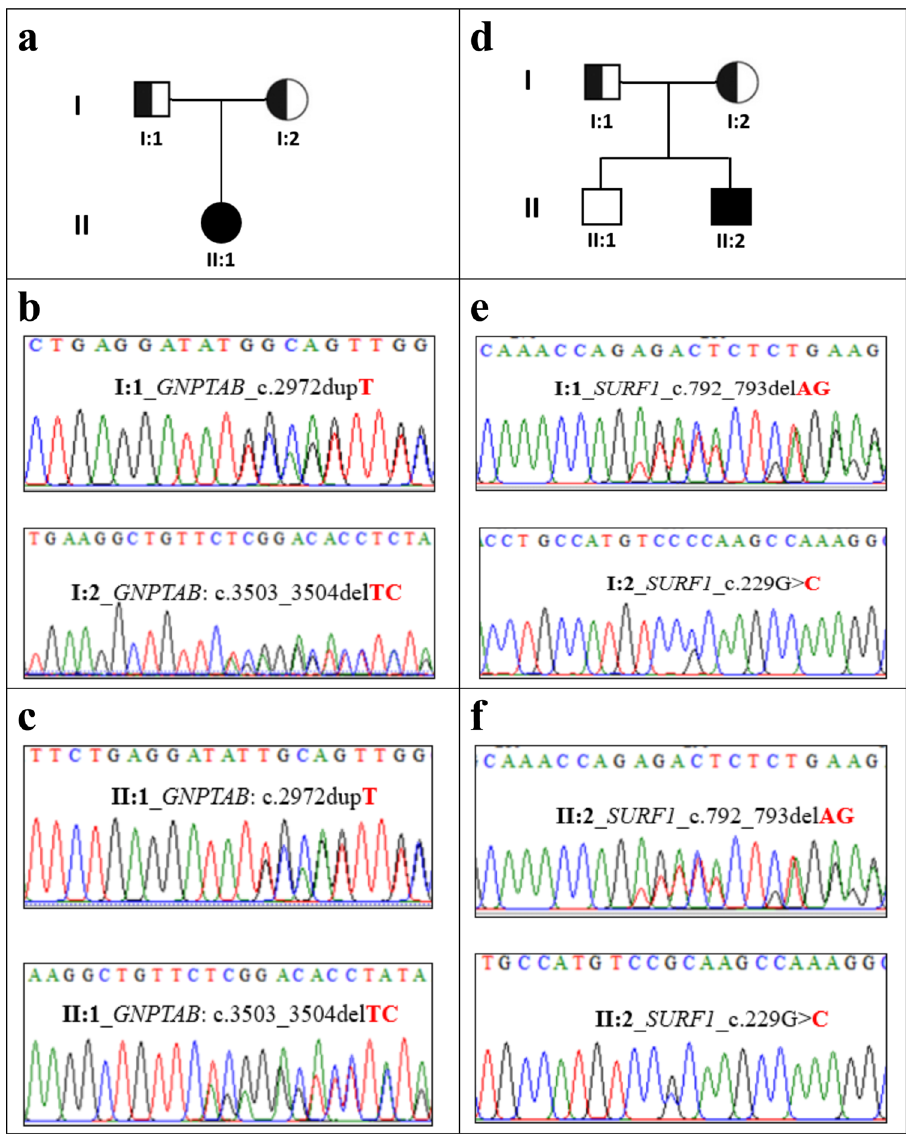
Fig. 1 Pedigree and Sanger validation of all compound heterozygous mutations in two unrelated non-consanguineous families (Patient 2 and 4, respectively). a , d Pedigree of two non-consanguineous families. Square indicates male and circle indicates female. The fi lled symbols represent affected individuals and partially fi lled symbols indicate carrier parents. Open symbols indicate healthy individual. b Chromatograms from Sanger sequencing of heterozygous GNPTAB mutations c.2972dupTand c.3503_3504delTCin father and mother, respectively. c Chromatograms from Sanger sequencing of compound heterozygous GNPTAB mutations c.2972dupT and c.3503_3504delTCin Patient-2. e Chromatograms from Sanger sequencing of heterozygous SURF1 mutations c.792_793delAGand c.229 G > Cin father and mother, respectively. f Chromatograms from Sanger sequencing of compound heterozygous SURF1 mutations c.792_793delAGand c.229 G > Cin patient-4. His elder brother (II:1) was apparently healthy and was not included in this